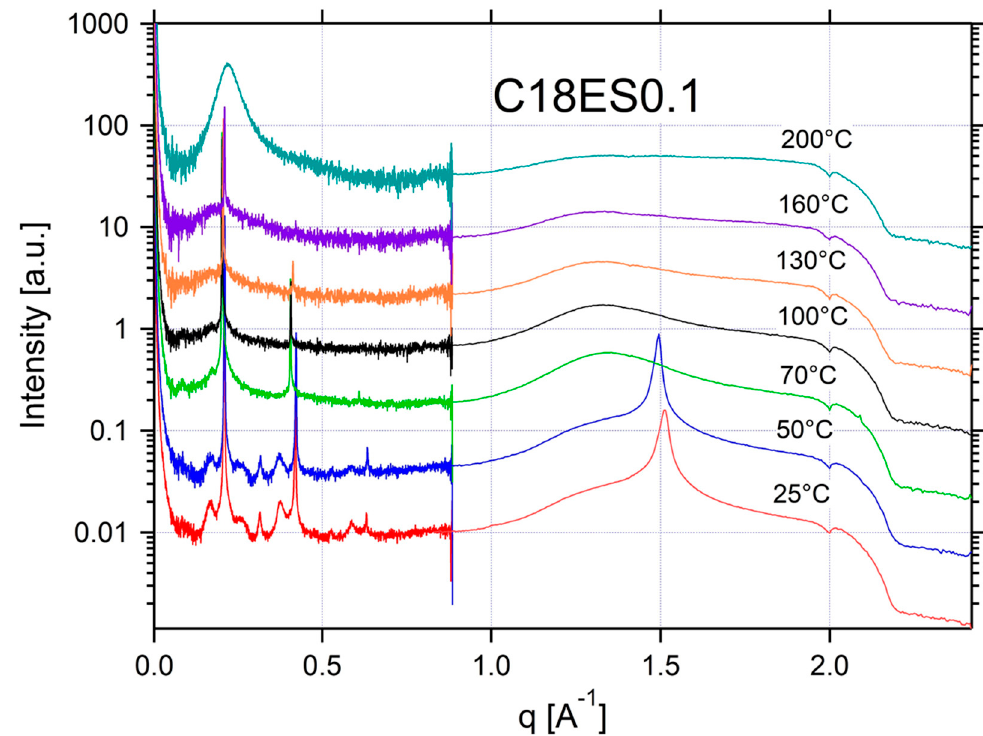
Figure A17. SAXS and WAXS data for 0.1:1 C18ES:C18LiTFSI.